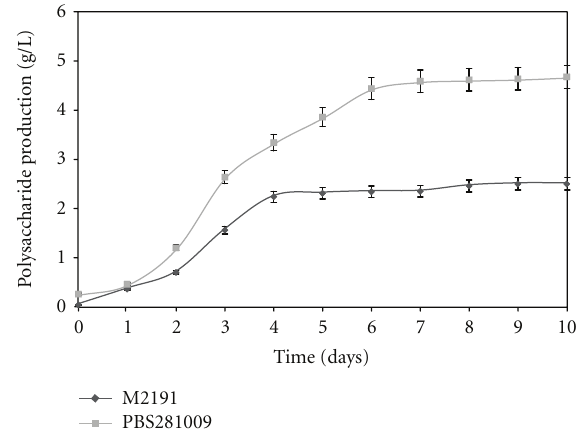
Figure 2: Polysaccharide production by submerged culture Pleuro- tus ostreatus M2191 and PBS281009 in a New Brunswick BioFlo 310